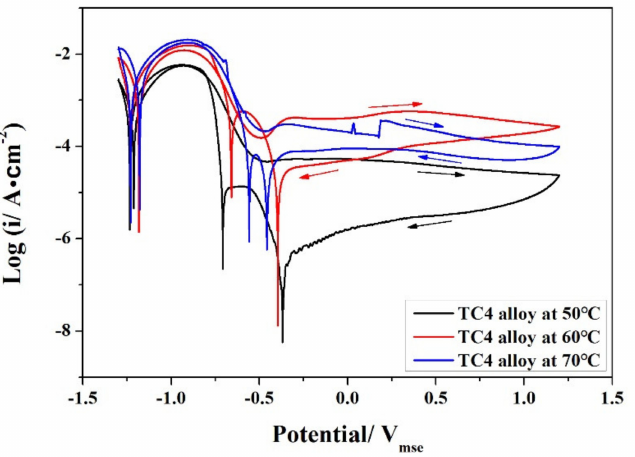
Figure 3. Potentiodynamic polarization curves of the TC4 alloy in 50 wt.% H 2 SO at 50–70 ◦